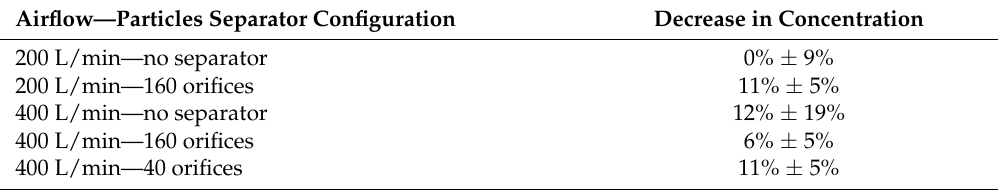
Table 1. Nanoparticles (10 nm–420 nm) total concentration difference between cages two and